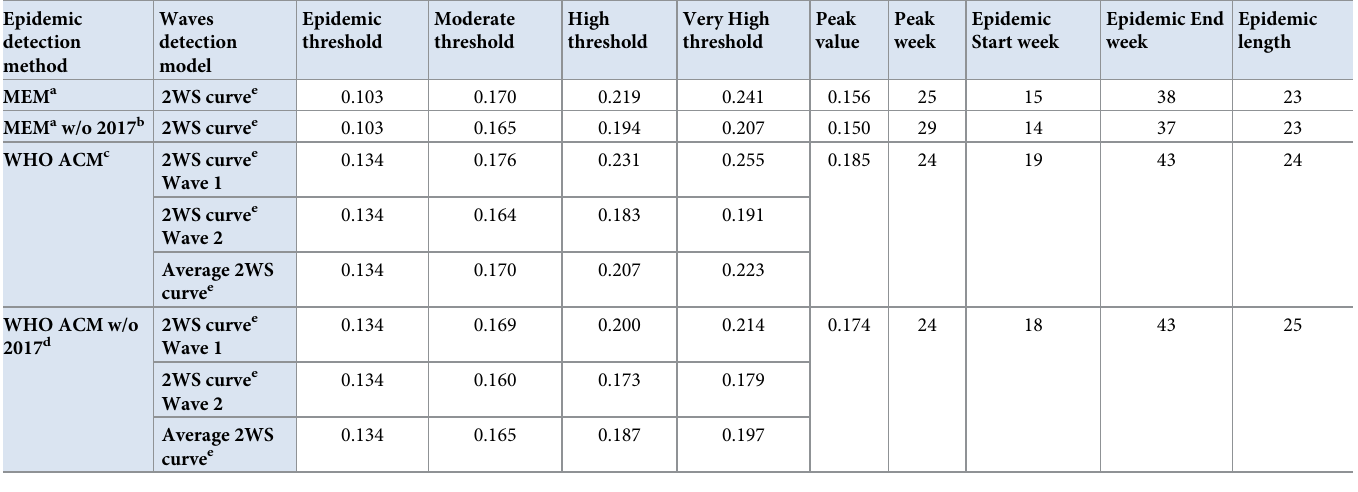
Table 1. Characteristics of the thresholds for MEM (with and without 2017) and WHO ACM (with and without 2017), by the different types of waves detection methods, Mauritius, ARI season 2012–2018. Epidemic